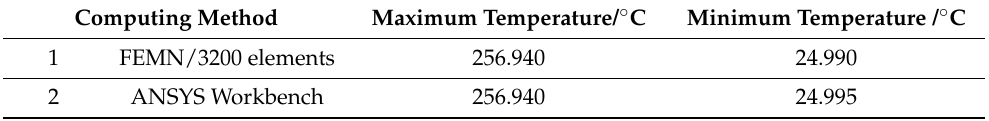
Table 4. Comparison of the upper and lower limits of temperature field.